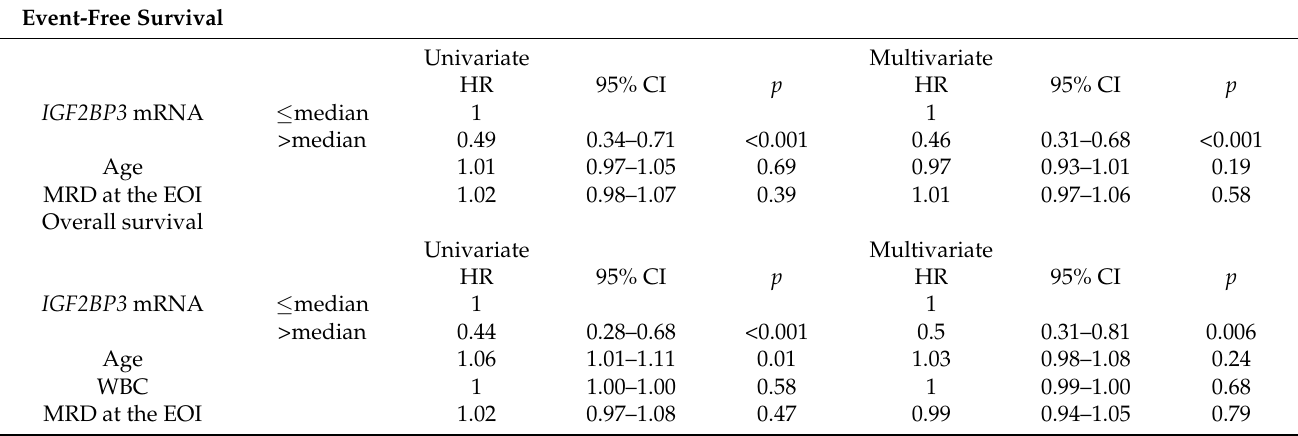
Table 2. Cox proportional hazards model for survival in the high-risk B-ALL TARGET cohort ( n = 155) [27,28]. Event-Free Survival